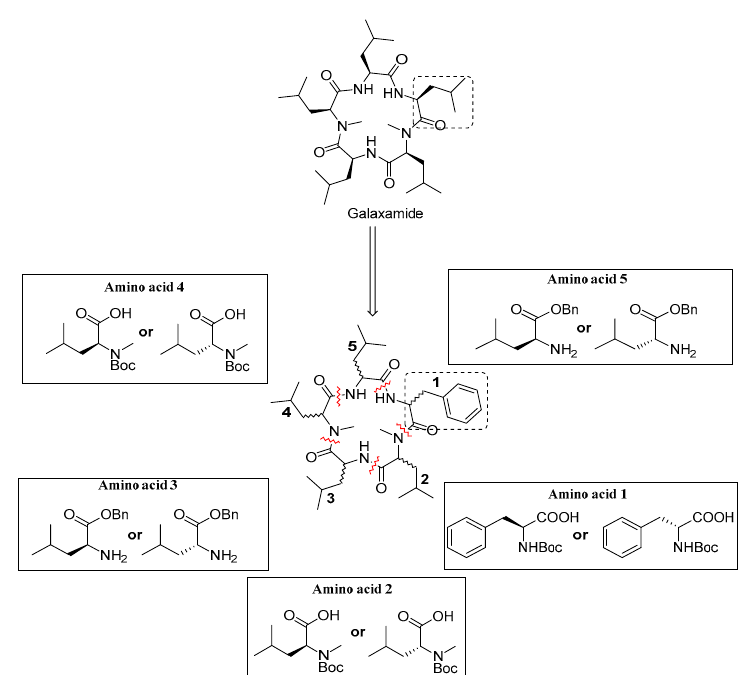
Figure 2. Amino acids used in the synthesis of Galaxamide analogs. Red wavy lines show the chemical bond where amino acid was replaced. Dash line boxes highlight leucine in Galaxamide has been replaced by phenylalanine in our Analogs. Amino acids in solid line boxes has D / L configuration.